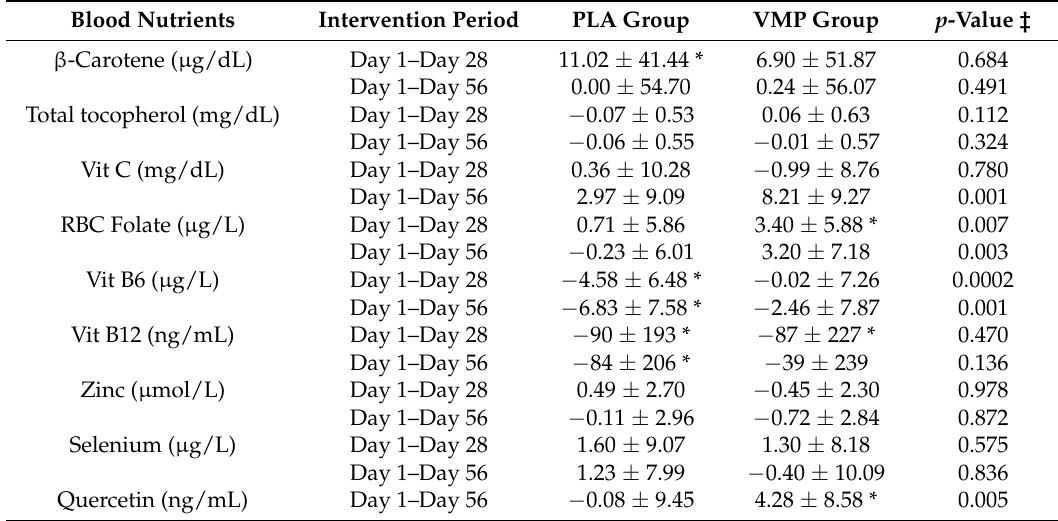
Table 5. Change in blood nutrient status after 28 and 56 days of dietary supplementation. Blood Nutrients Intervention Period PLA Group VMP Group p -Value ‡ β -Carotene ( µ g/dL)